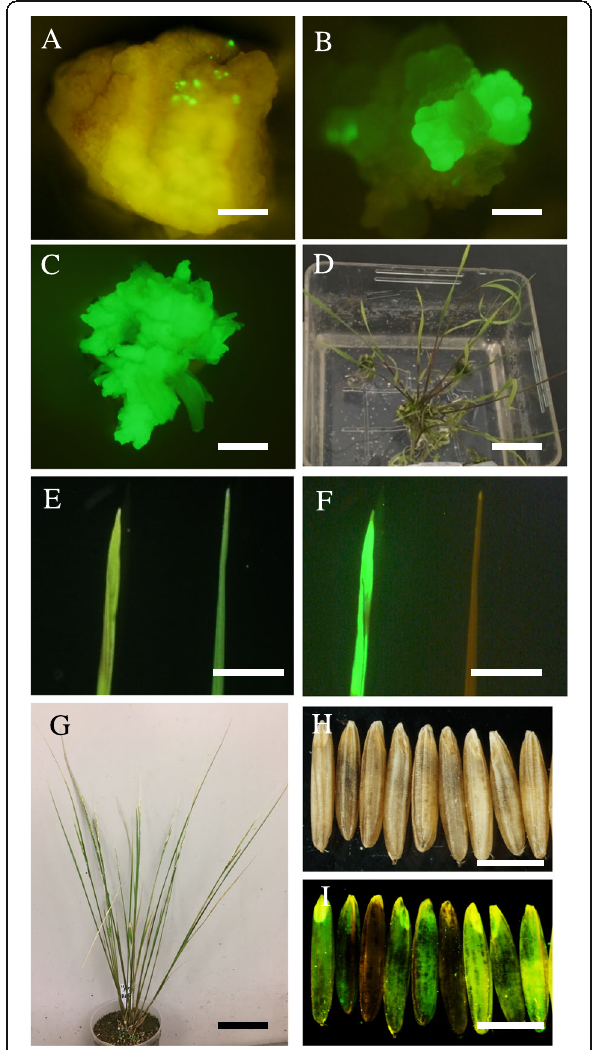
Fig. 1 Agrobacterium- mediated transformation of Oryza brachyantha W1711. a At 10 days after infection, GFP signals were observed in immature embryos. Bar = 1 mm. b Callus was cultured for 2 weeks on selection medium. Part of the callus showed a GFP signal. Bar = 2 mm. c After 2 weeks ’ culture on regeneration media, shoots with strong GFP signals were formed. Bar = 3 mm. d Regenerated plants on rooting medium. Bar = 2 cm. e , f Leaves through e bright field and f GFP filters: left, transgenic; right, non-transgenic. Bar = 1 cm. g Transgenic plants growing to maturity without morphological abnormalities. Bar = 5 cm. h , i T 1 seeds of a transgenic plant through h bright field and i GFP filters. T 1 seeds with and without GFP signal were segregated. Bar = 4